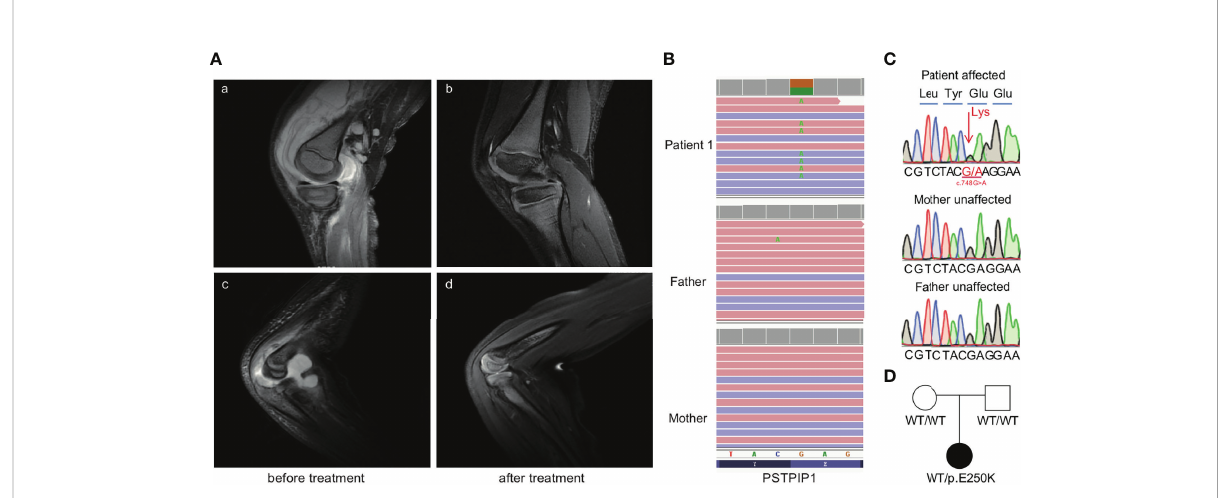
FIGURE 1 Clinical manifestation of pre- and post-treatment and con fi rmation of the PSTPIP1 mutation in the patient with PAMI. (A) T2WI MRI signals of knee and elbow joints pretreatment (A, C) and post-treatment (B, D) . (B) Exome sequencing reads covering the p.E250K variant in patient, displayed by the integrative genomics viewer. (C) Sanger sequencing con fi rmed the PSTPIP1 p.E250K variant. (D) Pedigree of the family with p.E250K variant in PSTPIP1.